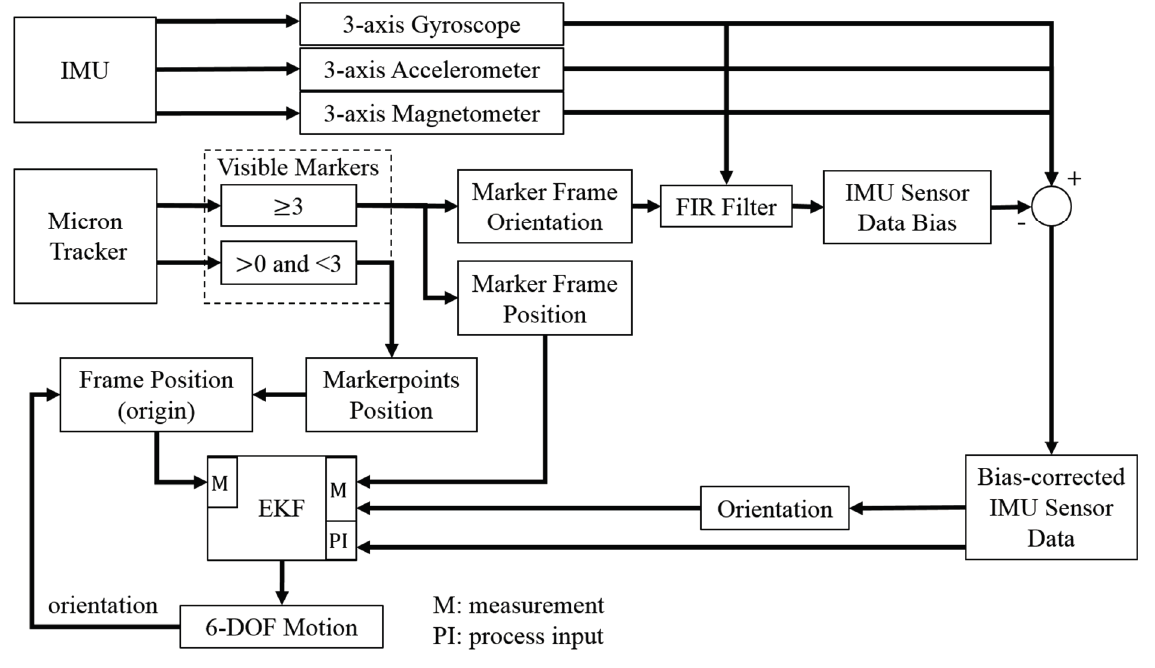
Figure 6. Fusion of inertial sensing to compensate for occlusions in OTS. If there is no occlusion, the MicronTracker can provide the position of the marker